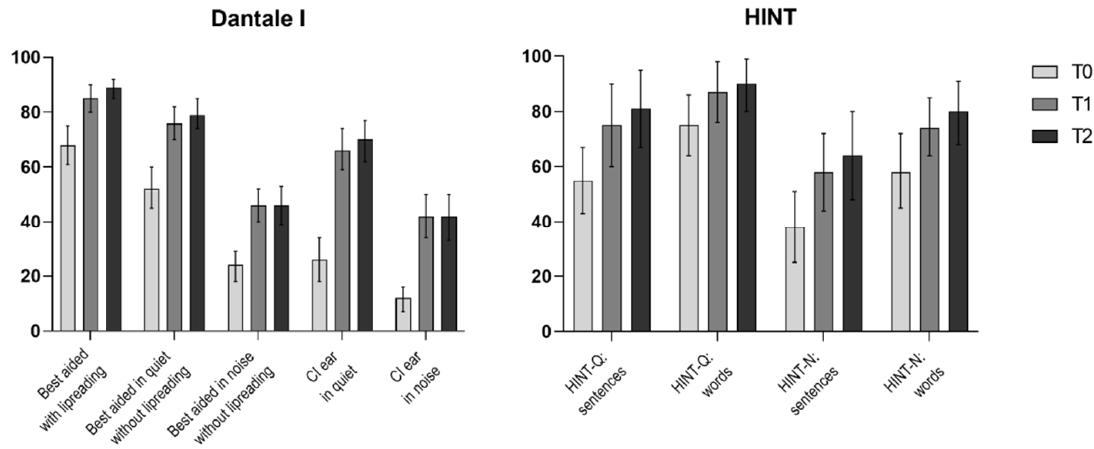
Figure 1. Scores in five Dantale and four HINT conditions at different time points (T0, T1, and T2) of the patient cohort ( n = 39) are represented in box plots. Columns present means and whiskers present 95% confidence intervals.